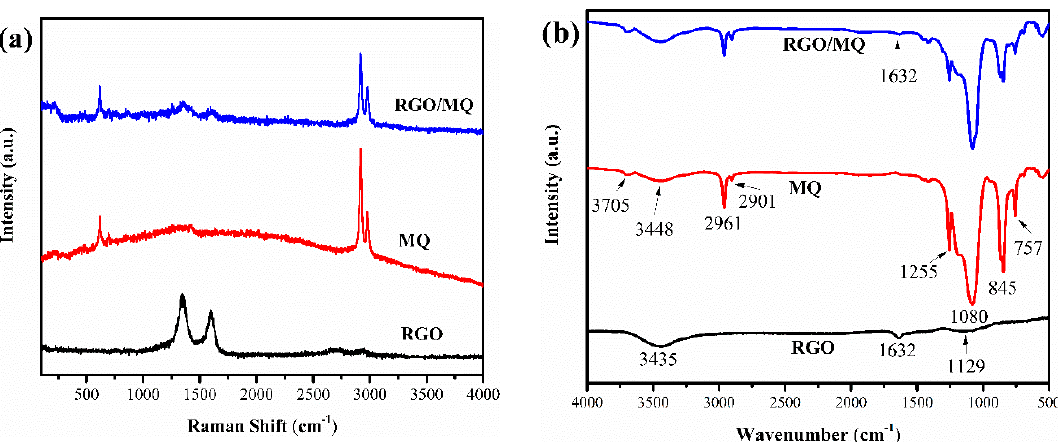
Figure 4. ( a ) Raman spectra of RGO, MQ and RGO/MQ; ( b ) Fourier transform infrared spectroscopy (FT-IR) spectra of RGO, MQ and RGO/MQ .